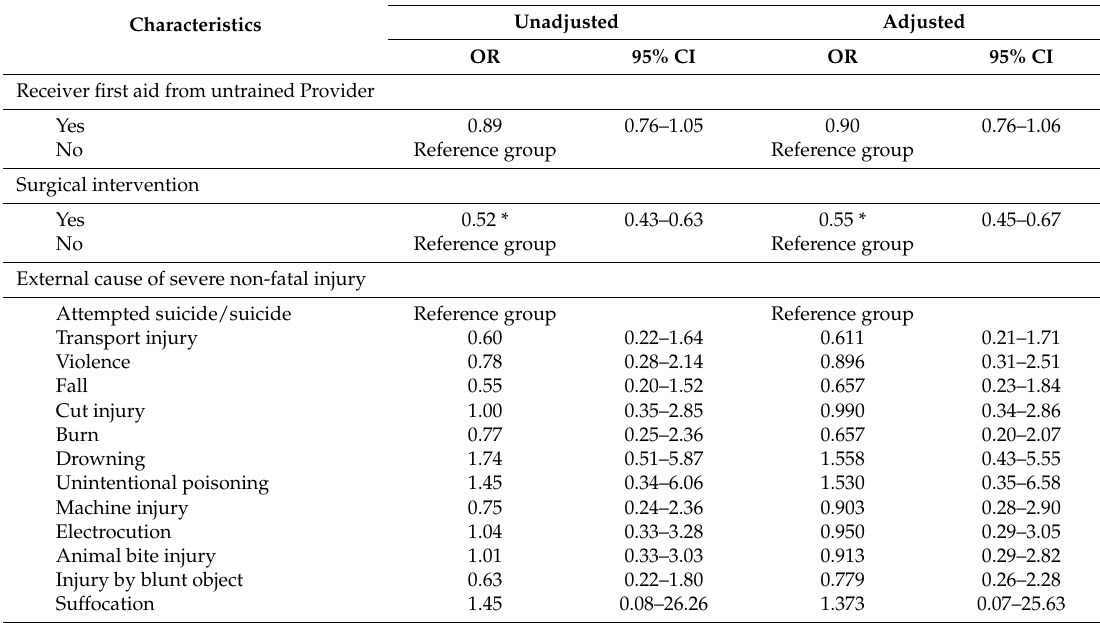
Table 7. Multivariate analysis of treatment outcomes by un-trained provider among severe non-fatal hospitalised